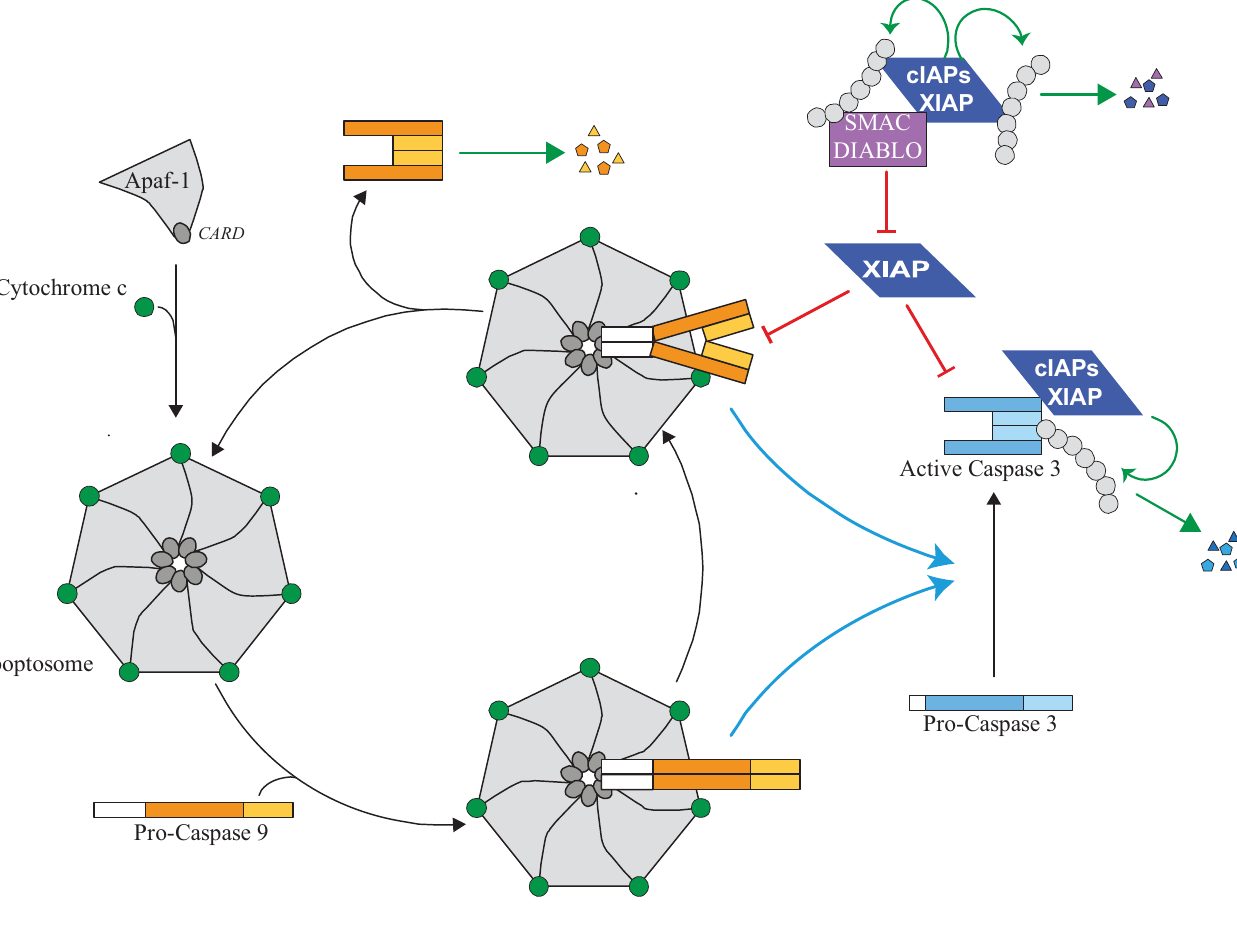
Figure 3. Regulation of the apoptosome and caspase activity by IAPs. The release of cytochrome-c from mitochondria which occurs during intrinsic pathway of apoptosis triggers an ATP-dependent conformational change and oligomerisation of the adaptor apoptotic protease activating factor 1 (Apaf-1) in a heptameric complex apoptosome. Apaf-1 then recruits Caspase-9 via its pro-domain through a homotypic CARD-CARD interaction. Caspase-9 is activated by homodimerisation and promotes the activating cleavage of effector caspase-3 leading to apoptosis. Caspase-9 undergoes autocatalytic processing and is then quickly disconnected from the apoptosome which is free to recruit a new pro-caspase-9. XIAP can control caspase activating pathway at several steps. First, XIAP is present in the apoptosome where it directly binds processed caspase-9 and inhibits its activity. The inhibition of caspase-9 by XIAP could stabilize the caspase-9 apoptosome complex and block the cycle of caspase-9 activation. Second, XIAP can directly bind and inhibit active effector caspase-3. XIAP can inhibit caspase activity by hindering substrate accessibility or hiding the protease catalytic residue, and/or by promoting ubiquitination or neddylation. Although unable to inhibit their activity, cIAP1 can bind to processed caspases and promote their ubiquitination. An IBM-dependent binding of IAP antagonists such as Smac/Diablo prevents XIAP-mediated caspase inhibition while cIAPs could interfere with neutralizing binding